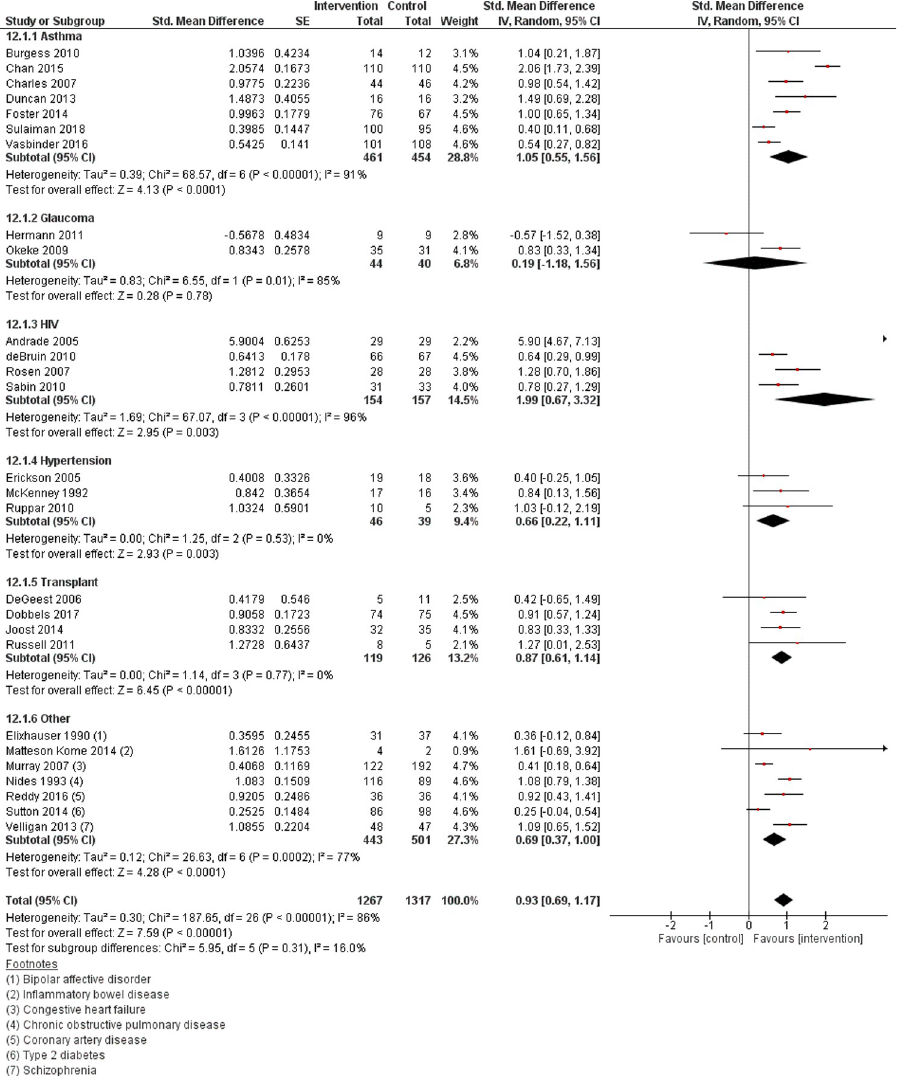
Fig 2. Forest plot of effect of the electronic adherence monitoring intervention compared to control on medication adherence for studies with available data (n = 27) by chronic condition. SE, standard error; CI, confidence intervals for effect